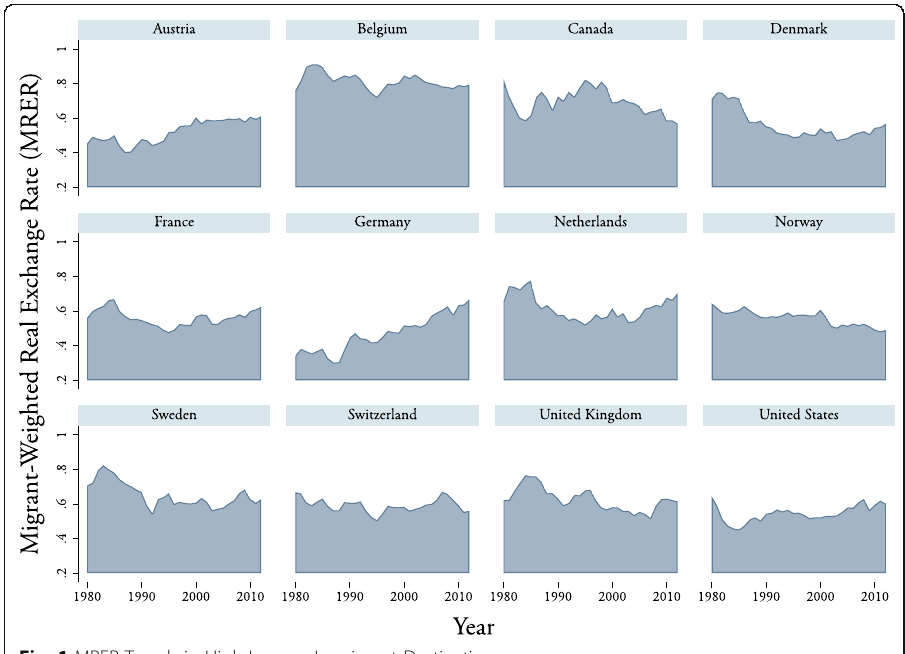
Fig. 1 MRER Trends in High-Income Immigrant